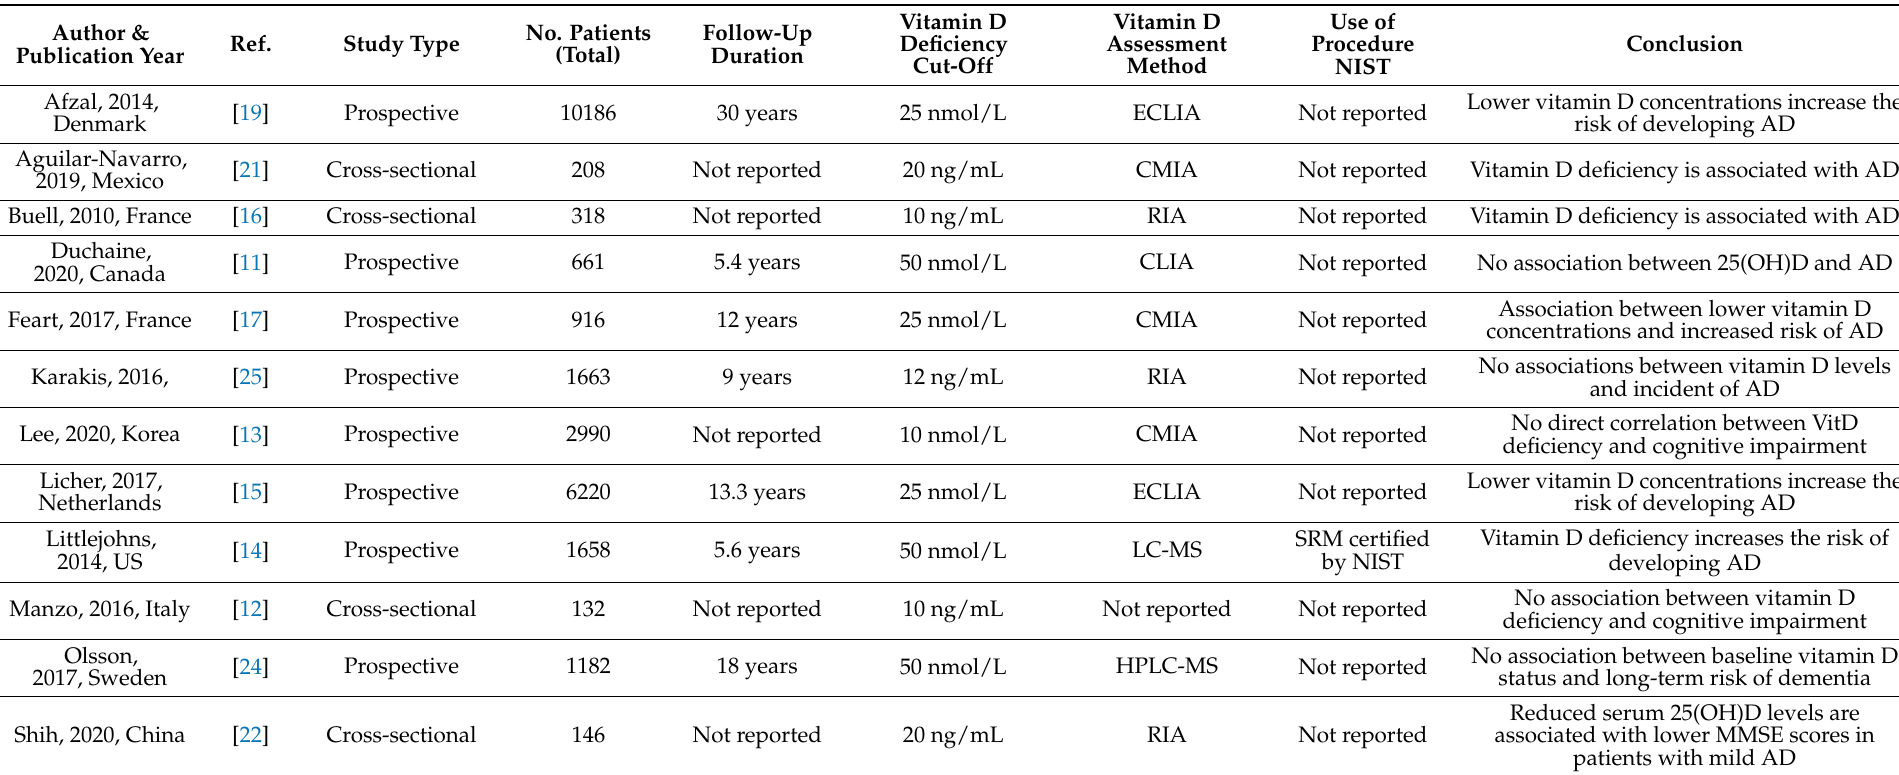
Table 1. Characteristics of studies included in the analysis of vitamin D deficiency and the risk developing Alzheimer